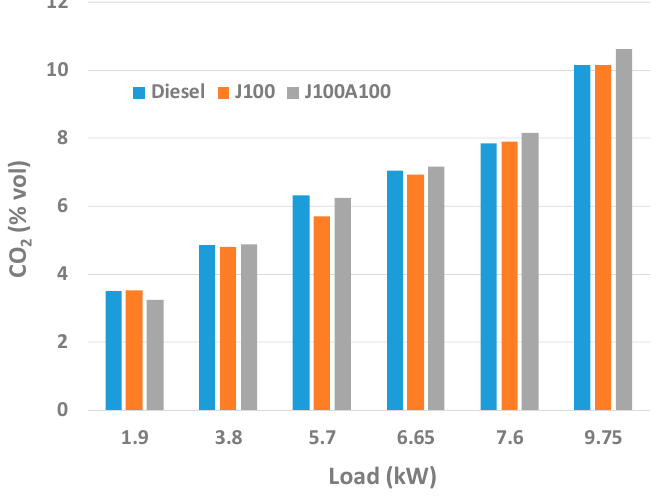
Figure 7. CO 2 emission vs. engine load.